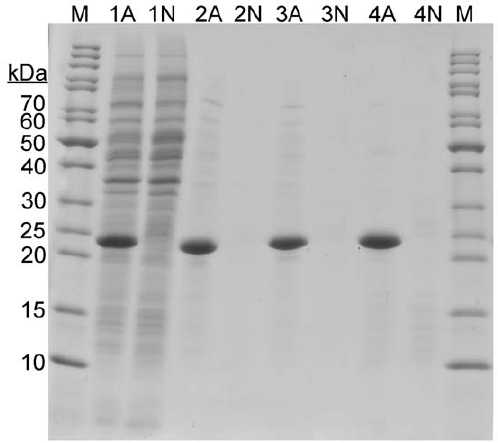
Figure 1. SDS-PAGE analysis of samples from different stages of purification of recombinant amelogenin from E.coli cells. Lanes marked with (A) represent samples from cells expressing amelogenin and lanes marked with (N) refers to negative control cells harboring empty expression vector. Lanes marked with (1) represent whole cell samples after cultivation. Lanes marked (2), (3) and (4) represent samples after different treatments of the intact cells. (2): soluble fractions of cells sonication in 3% HAc. (3): soluble fractions after heat treatment of the sonicated samples in lanes 2A and 2N. (4): soluble fractions of cells directly heat treated at 80 u C. This generates the most pure amelogenin. Lanes marked (M) contain molecular weight markers.